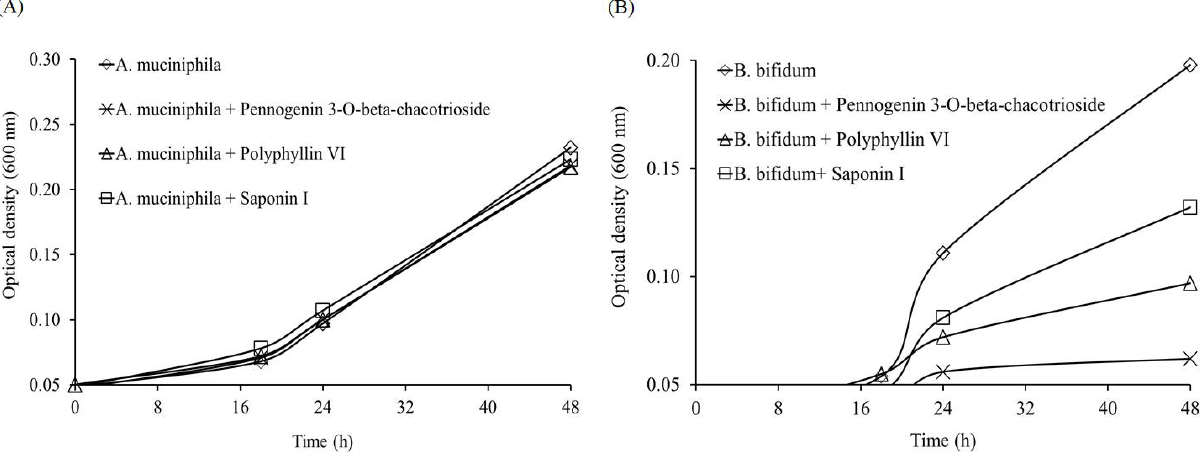
Figure 9. Effect of pennogenin 3- O -beta-chacotrioside, polyphyllin VI, and saponin I (5 μM) on the growth curve of ( A ) Akkermansia muciniphila and ( B ) Bifidobacterium bifidum .